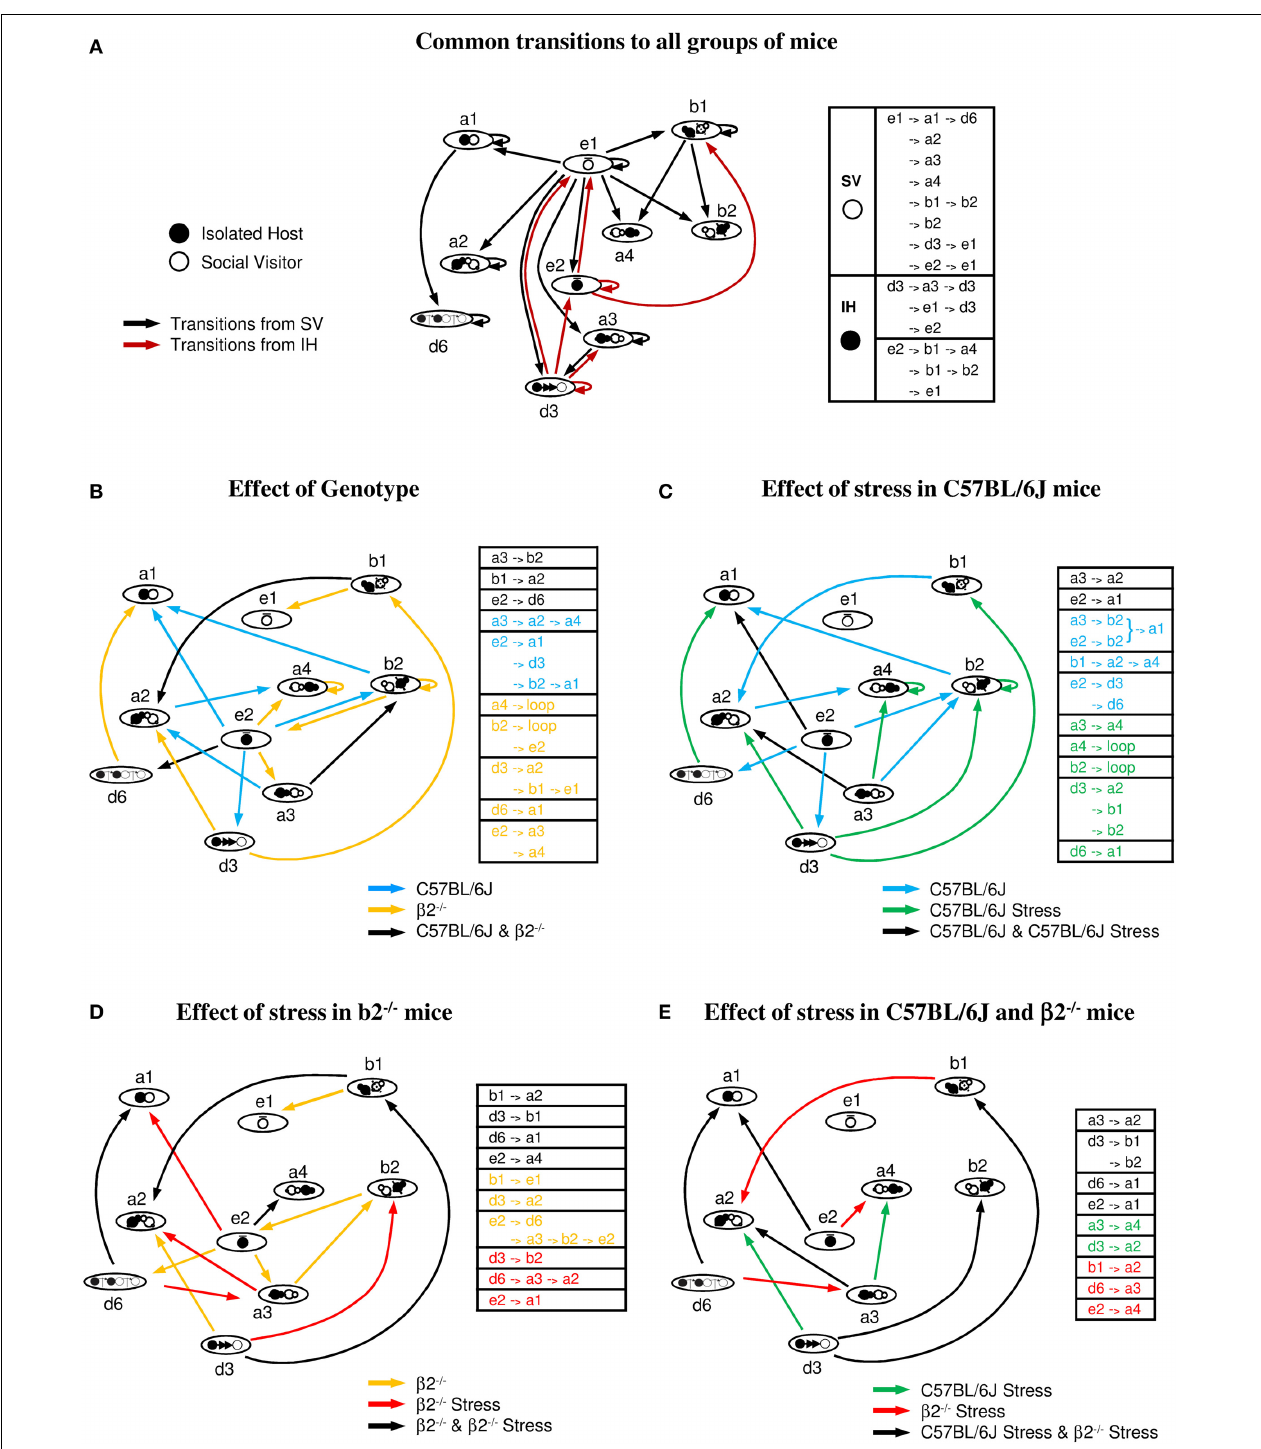
(blue arrows) and C57BL/6J stressed mice (green arrows). (D) Effect of stress in β 2 − / − mice:common(blackarrows)andspecifictransitionsto β 2 − / − (yellow arrows) and β 2 − / − stressed mice (red arrows). (E) Effect of stress in C57BL/6J and β 2 − / − mice: common (black arrows) and specific transitions to C57BL/6J stressed (green arrows) and β 2 − / − stressed mice (red arrows). Tables next